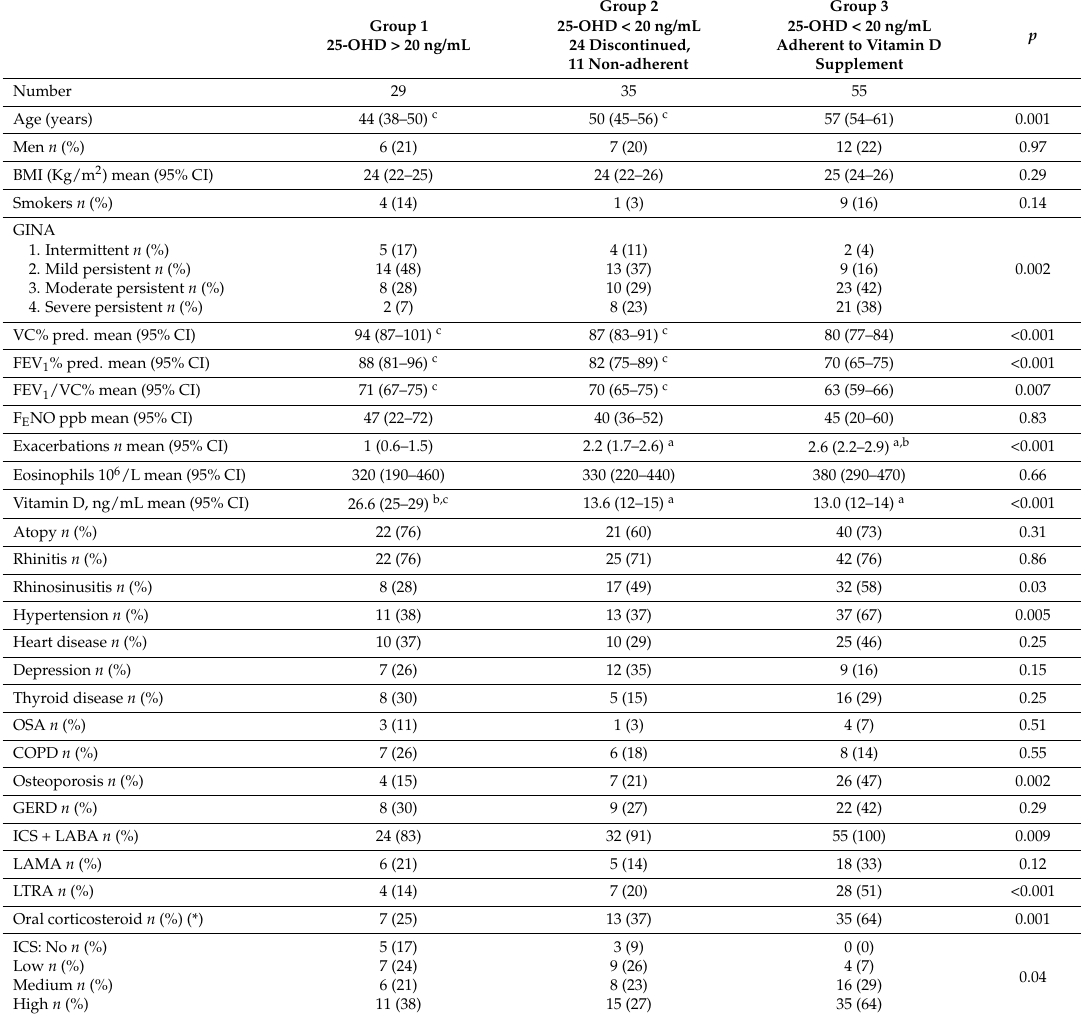
Table 2. Comparison among patients with and without vitamin D deficiency at the beginning of 12 month supplementation